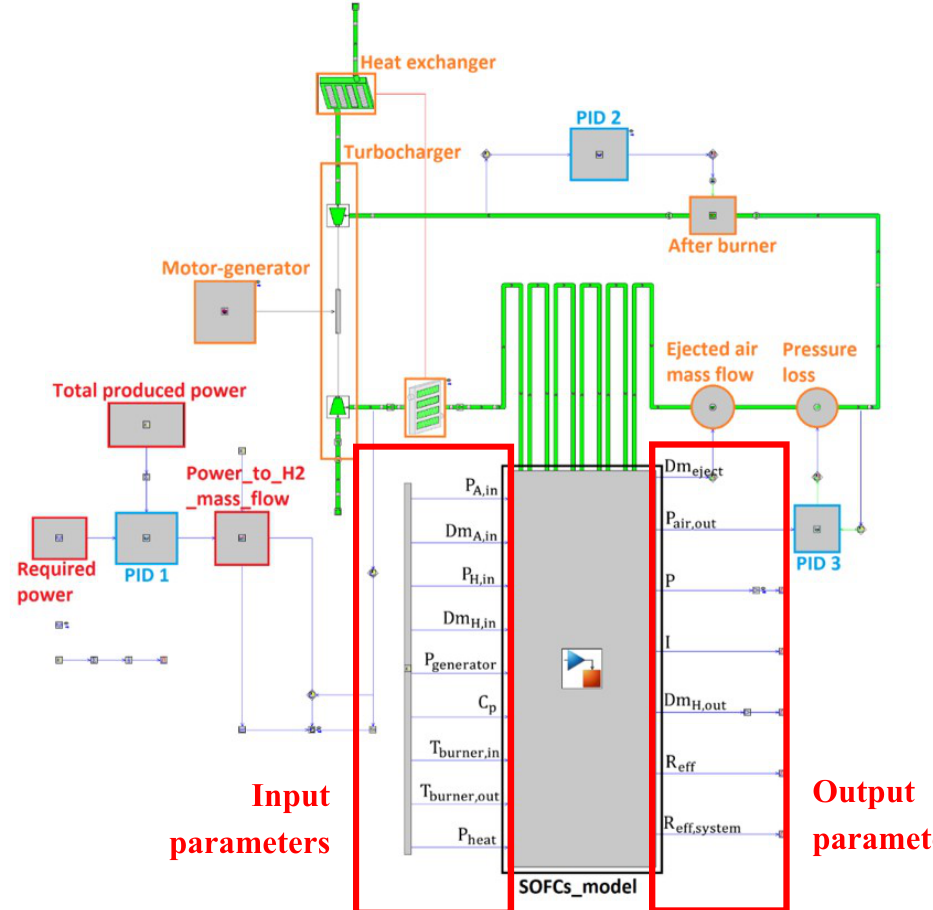
Figure 5. GT-SUITE model of the 5 kW SOFCs stack.